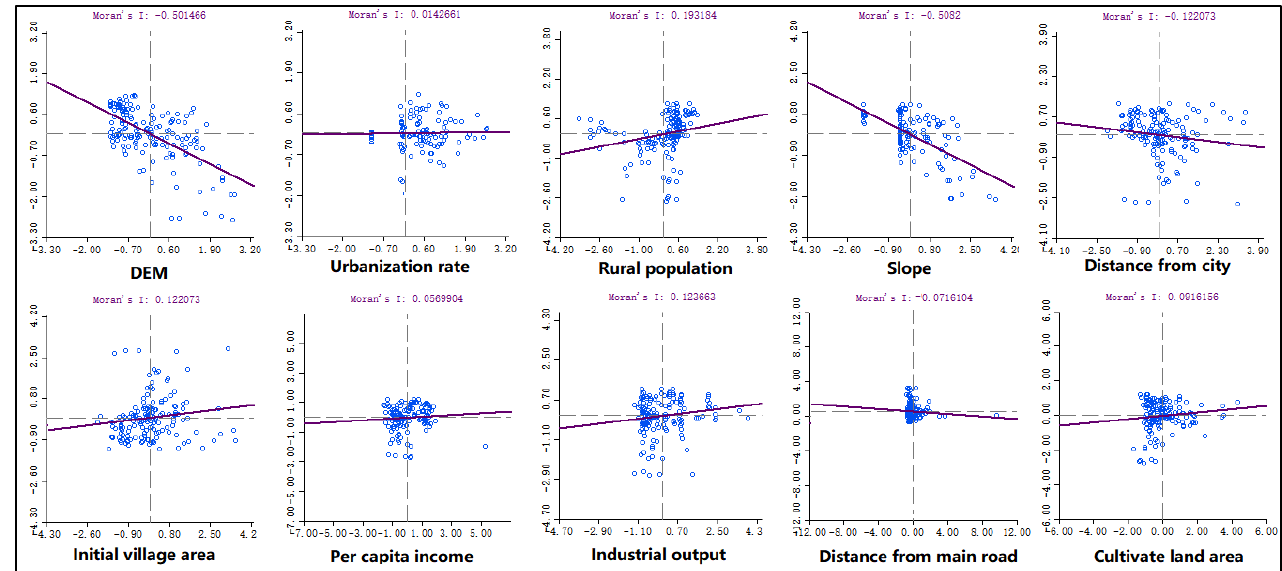
Figure 12. 2 period elasticity coefficient local spatial correlation aggregation map.